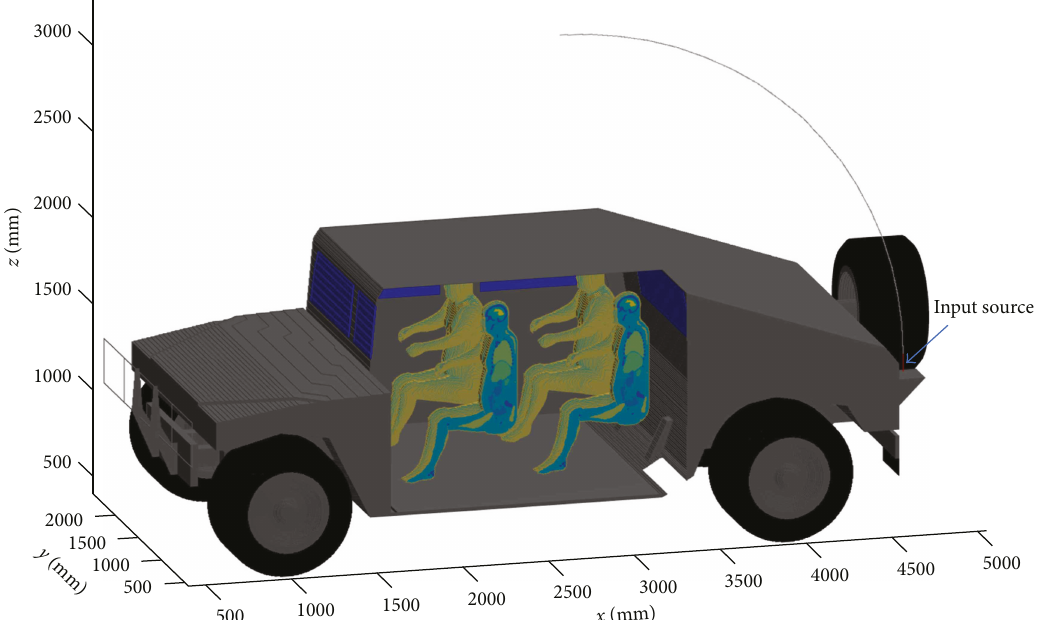
Figure 4: 3D model of the Humvee with four human bodies inside.